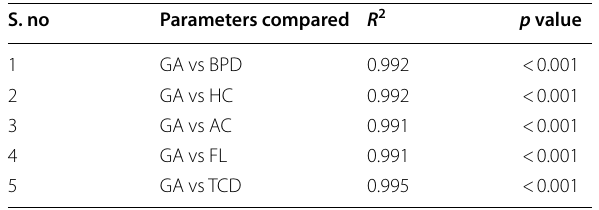
Table 2, of which TCD shows better regression values. BPD, HC, AC and FL was correlated with TCD using regression analysis as given in Table 3, of which FL shows good correlation with TCD. Multiple linear regression equation to